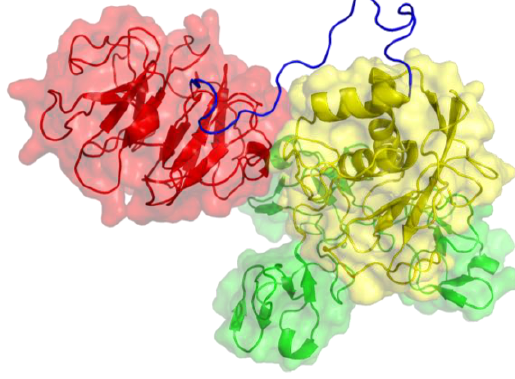
Figure 2. Three-dimensional structure of MMP-2. The catalytic (CAT) domain is yellow, the linker/hinge is blue, the hemopexin-like (HPX) domain is red, and the fibronectin type II [FN(II)] inserts are green. The structure is based on X-ray crystallographic analysis of full-length MMP-2